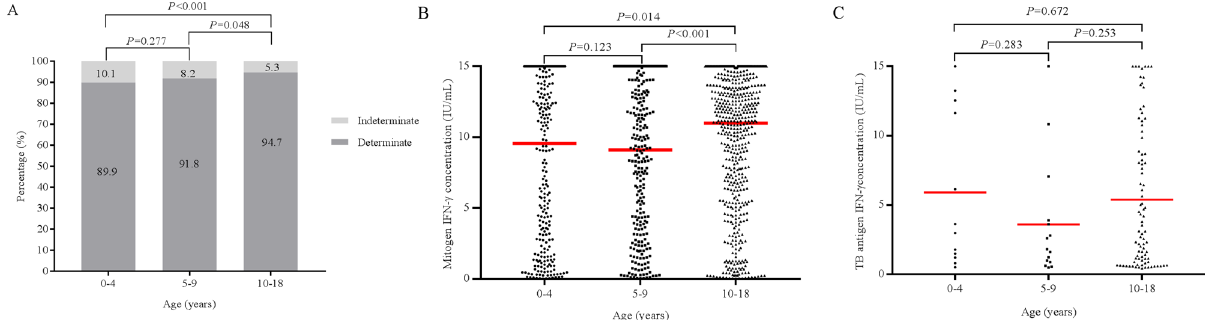
Figure 2. ( A ) Proportion of indeterminate QFT-GIT results in group A (< 4 years old), B (5 to 9 years old), and C (10 to 18 years old). ( B ) IFN-γ response to the mitogen control PHA (censored at 15 IU/mL) according to the age group. Red lines indicate the median values. P values were calculated using the Mann–Whitney U test. ( C ) IFN-γ response to the TB antigens (censored at 15 IU/mL) according to age of children with a positive QFT-GIT result. The red lines indicate the median values. P values were calculated using the Mann–Whitney U test. QFT- GIT QuantiFERON-TB Gold In-Tube, PHA phytohemagglutinin, IFN-γ interferon-gamma, TB